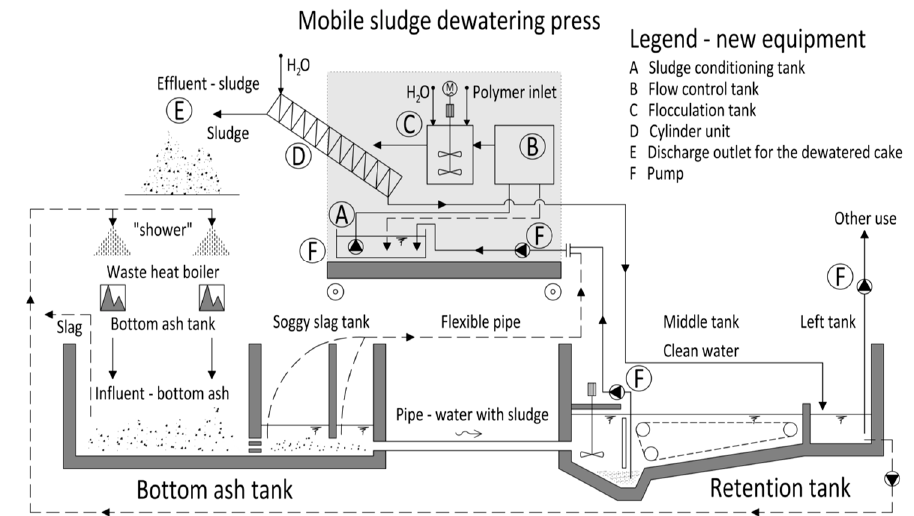
Figure 2. Process diagram of optimized